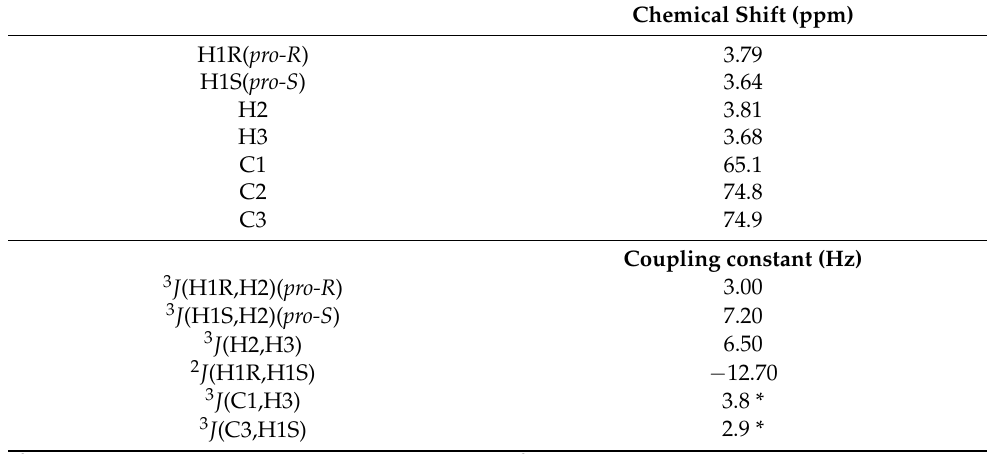
Table 2. 1 H and 13 C chemical shift and coupling constant of ribitol determined in this